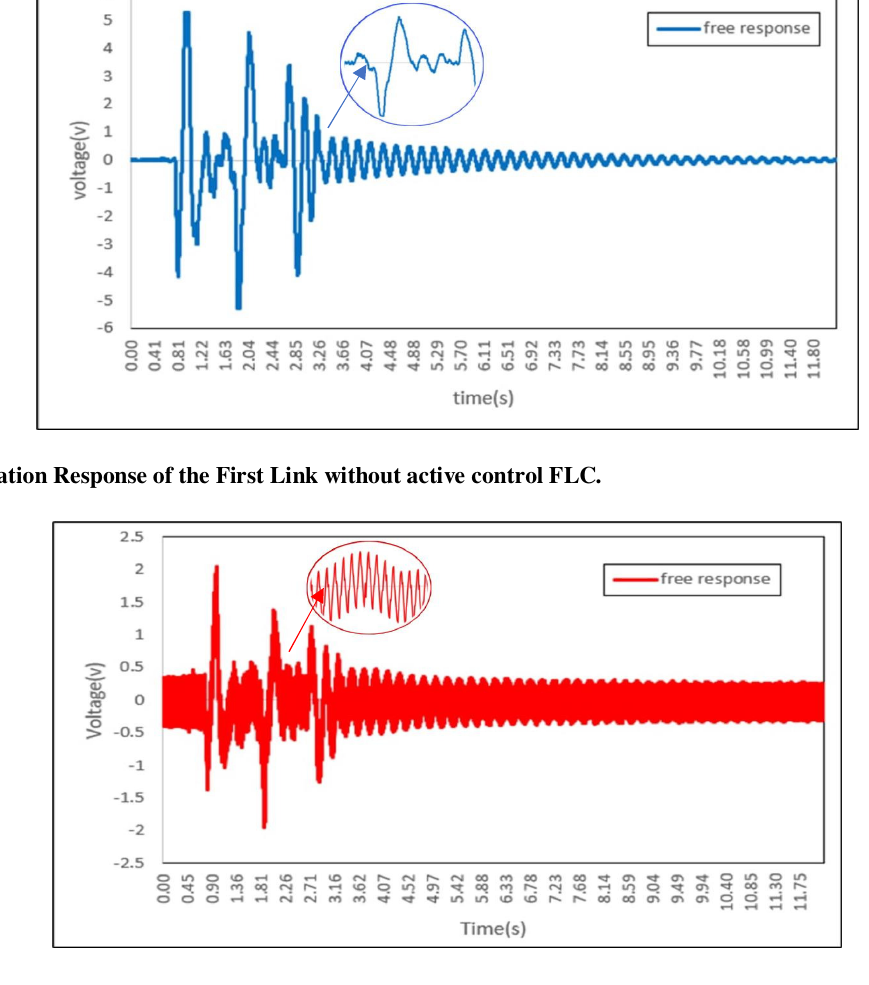
Fig. 8. Vibration Response of the Second Link without active control FLC.